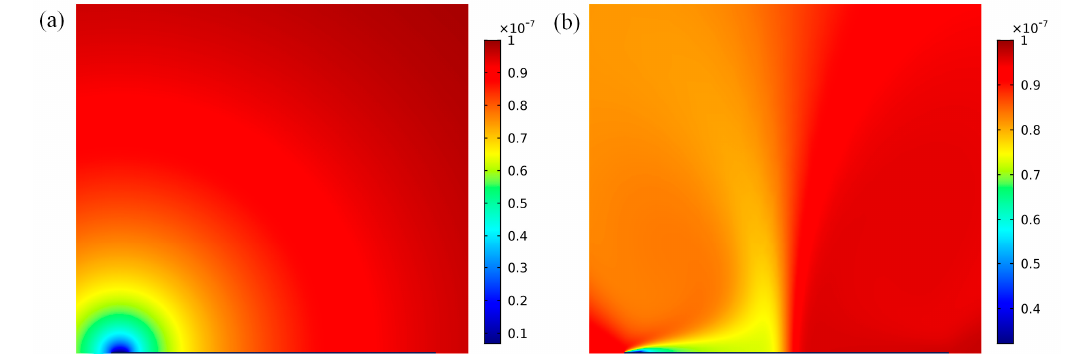
Figure 2. Simulation of antigen concentration distribution above the functionalized surface at 100 s for the following two cases. ( a ) Antigen concentration distribution with no external electrical field exerted, leaving mass transport diffusion on the floating surface only; ( b ) The ICEO circular flow redistributed the depleted concentration after the driving electrodes were energized with the electrical field of 4 V at 10 Hz.